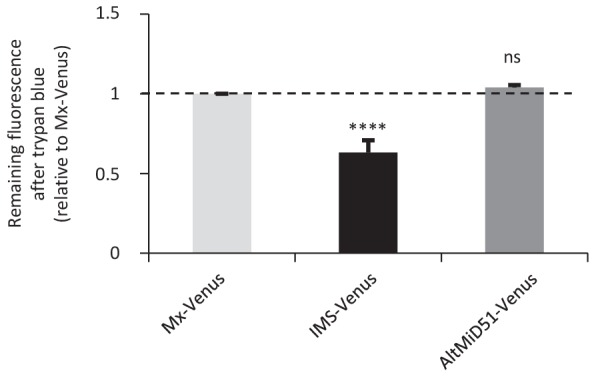
AltMiD51 is localized in the mitochondrial matrix.Trypan blue quenching experiment performed on HeLa cells stably expressing the indicated constructs: Matrix-Venus (Mx-Venus) and Intermembrane space-Venus (IMS-Venus). The fluorescence remaining after quenching by trypan blue is shown relative to Matrix-Venus (Mx-Venus) indicated by the dashed line. (****p<0,0001, one-way ANOVA). The absence of quenching of the fluorescence compared to IMS-Venus indicates the matricial localization of altMiD51. n ≥ 3 cells were quantified per experiment, and results are from six independent experiments. Data are mean ±SEM.